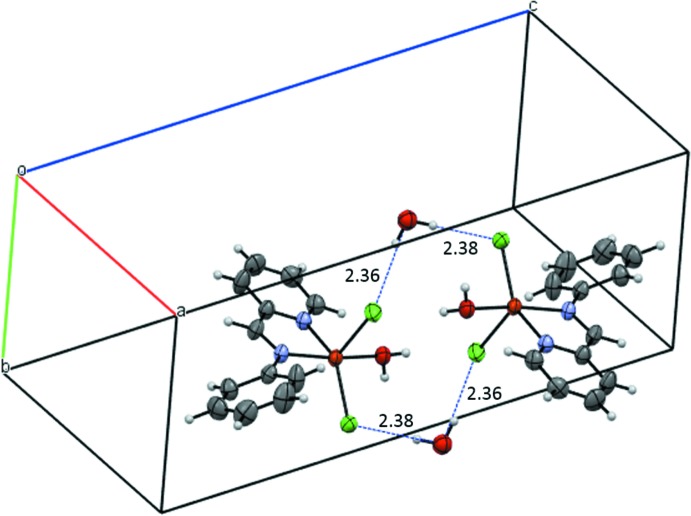
Symmetric cyclic dimers in the crystal structure of the title complex formed by dual Cl⋯H—O—H⋯Cl inter­actions (dotted blue lines) between the chlorine ligands and the water mol­ecules.